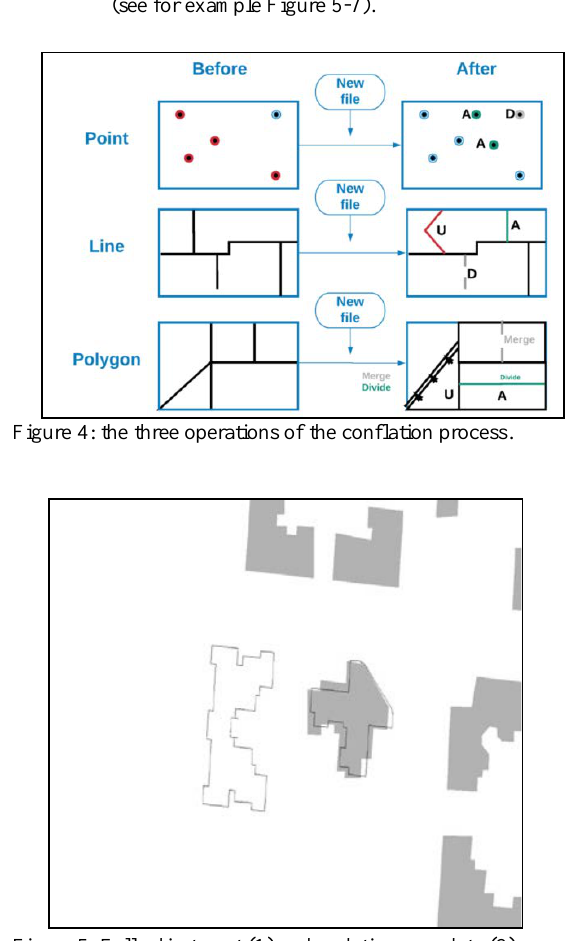
and transform corresponding segments and objects (see for example Figure 5-7).